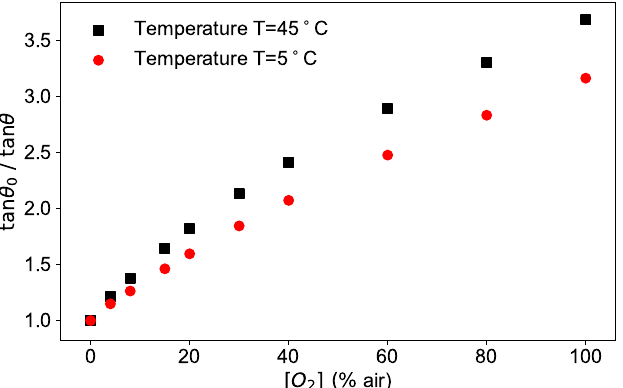
Figure 3. Phase shift measured for modulation frequency 2 πω = 6 kHz, at two different temperatures (5 ◦ C and 45 ◦ C) as a function of the oxygen concentration.